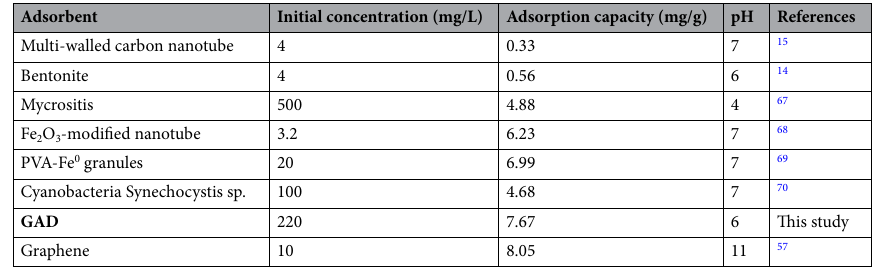
Table 4. Comparison of the adsorption capacity of Sb(III) onto various adsorbents.